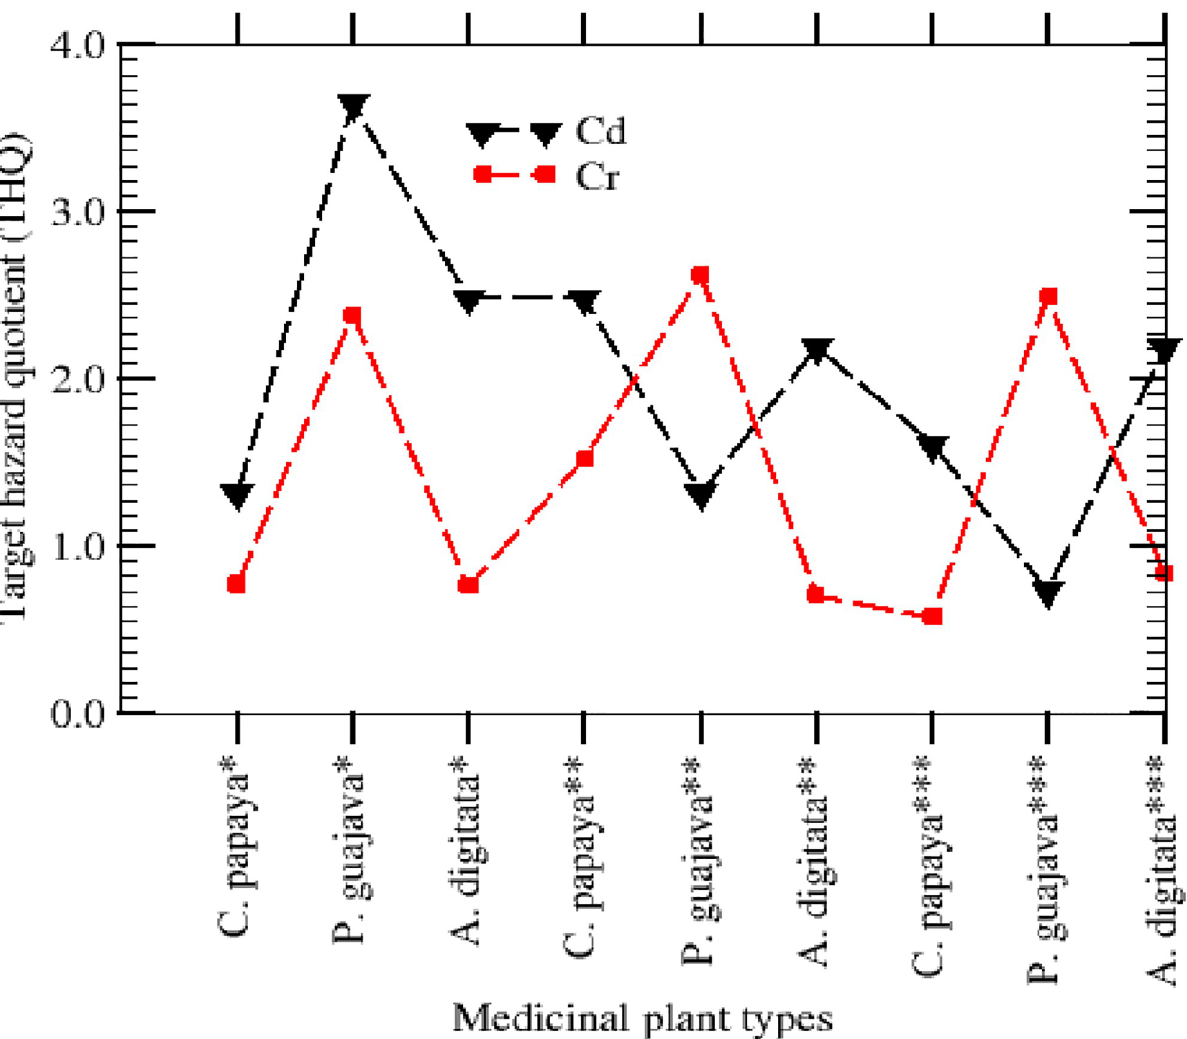
Fig 2. Target hazard quotient due to consumption of three herbs from Kano, Jigawa, and Borno states.